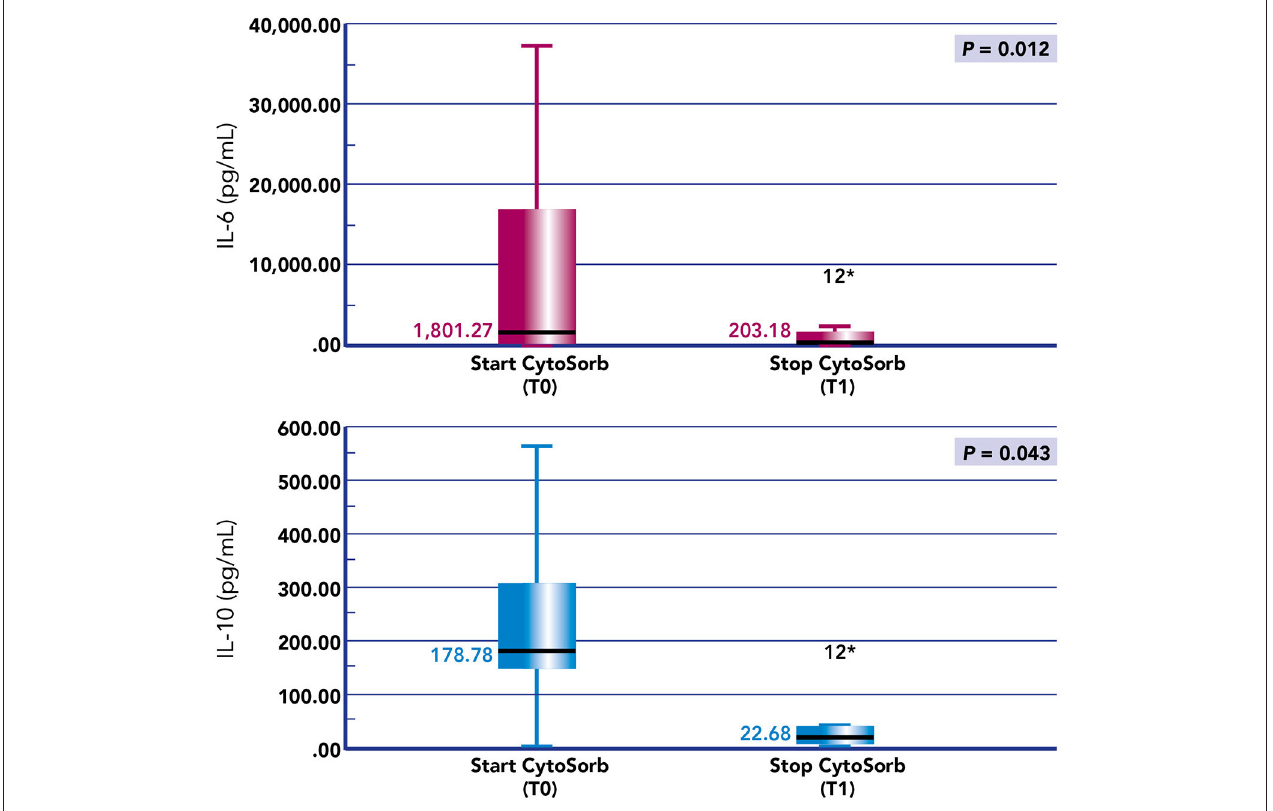
FIGURE 5 | Box plots of IL-6 and IL-10 before and after hemoperfusion with CytoSorb in our cohort of pediatric patients with septic shock. * p -value < 0.05.